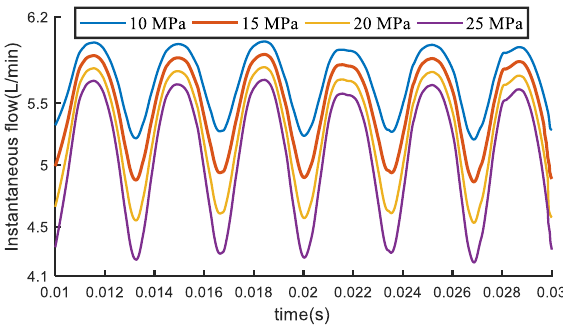
Figure 8. Contrast curves of simulated instantaneous flow of gear pumps under different pressure differences.